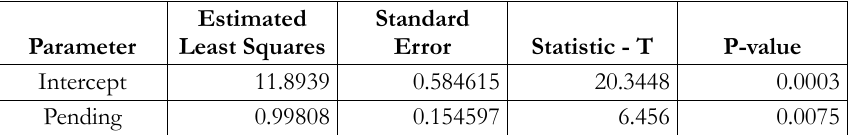
Table 6. ANOVA analysis statistics – Source Statgrafics Centurion XVI